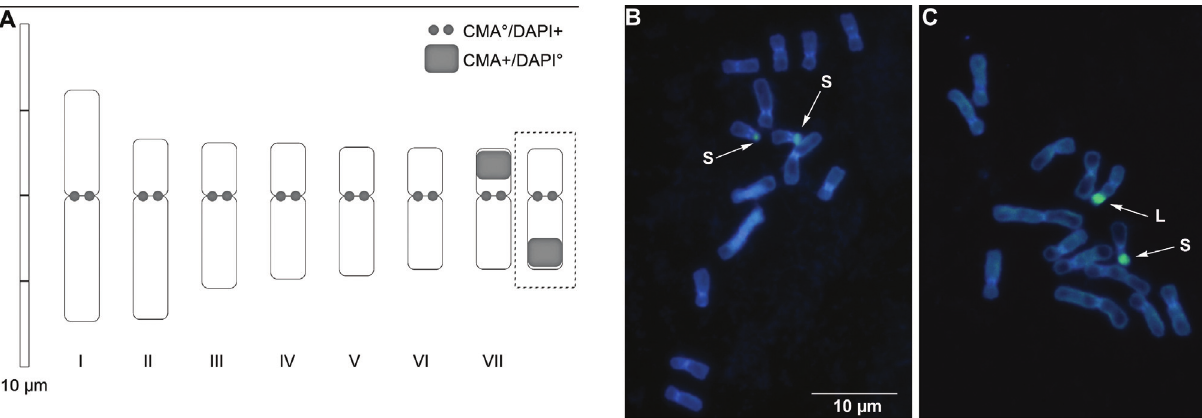
Figure 4 - Idiogram and fluorescent chromosome banding with CMA/DAPI on somatic chromosomes of Calydorea crocoides . A) Idiogram showing seven chromosome pairs. Inside the dotted box, a chromosome variant found of pair seven (ESC688), with an inversion of the GC-rich DNA region (CMA + /DAPI°). B) and C) Metaphase plates with fluorochrome banding. Arrows indicate CMA + /DAPI° location on the long arm, L, and on the short arm,